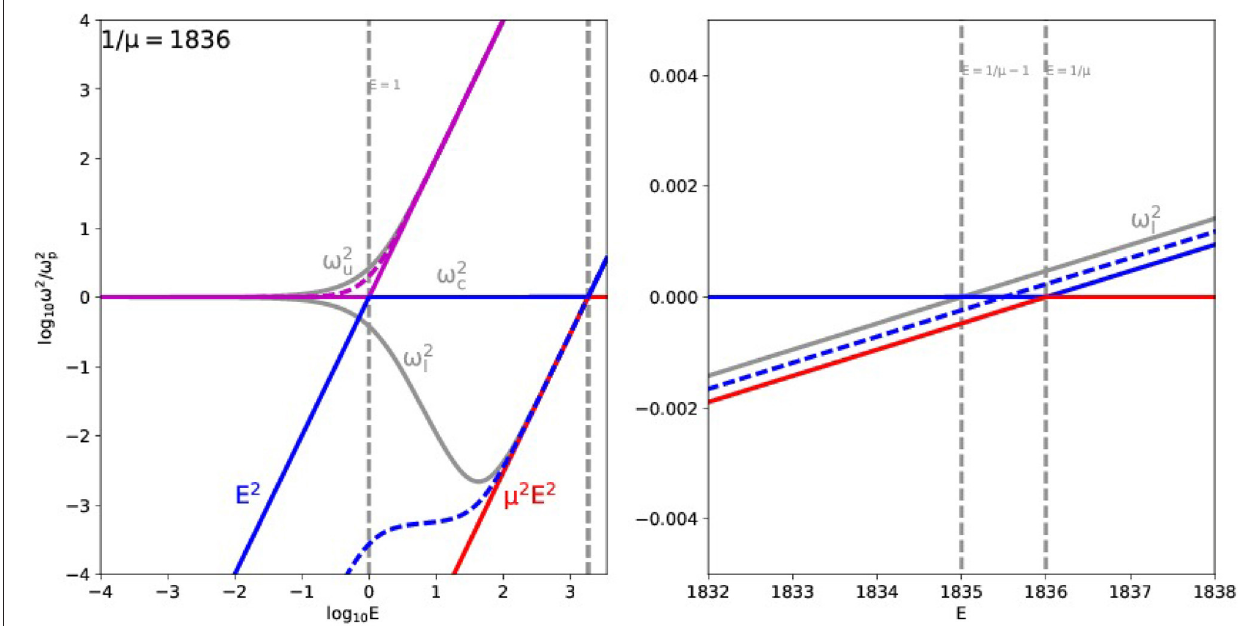
1 /µ . Note the = 1, E 1 /µ 1 and E 1 /µ . = = − =